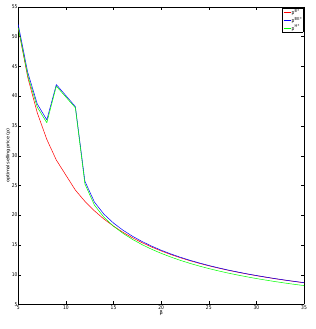
Figure 4. The influences of β on the retail price p